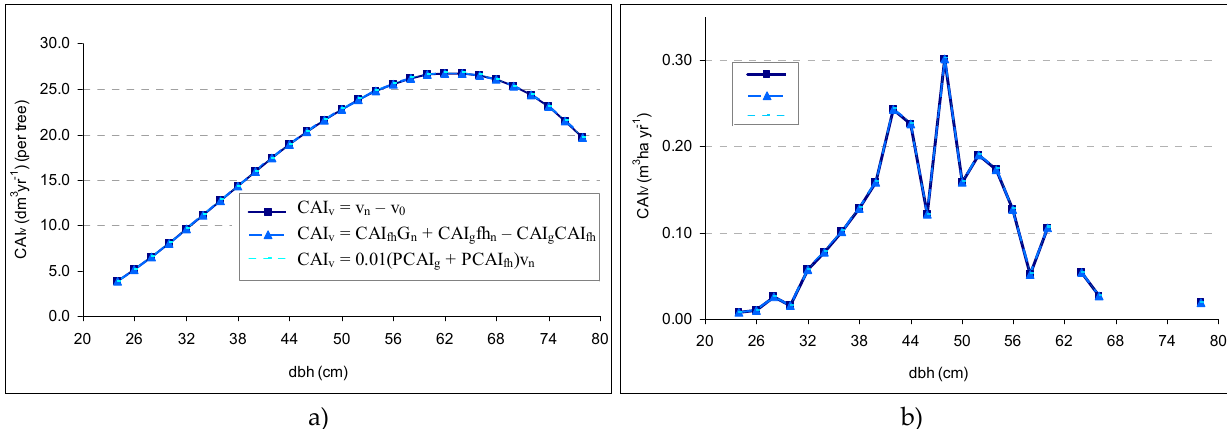
Figure 3. Current annual volume increment for individual trees ( a ) and stand ( b ). By applying the simplified Equation (7), the volume difference compared to The Mean Tree of the Stand Equations (2) and (4) was